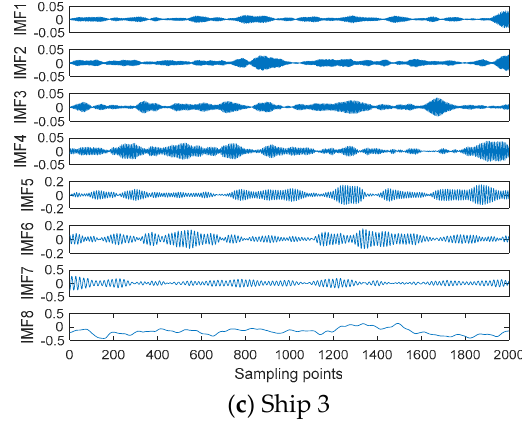
Figure 11. The VMD results of ship-radiated noise samples.